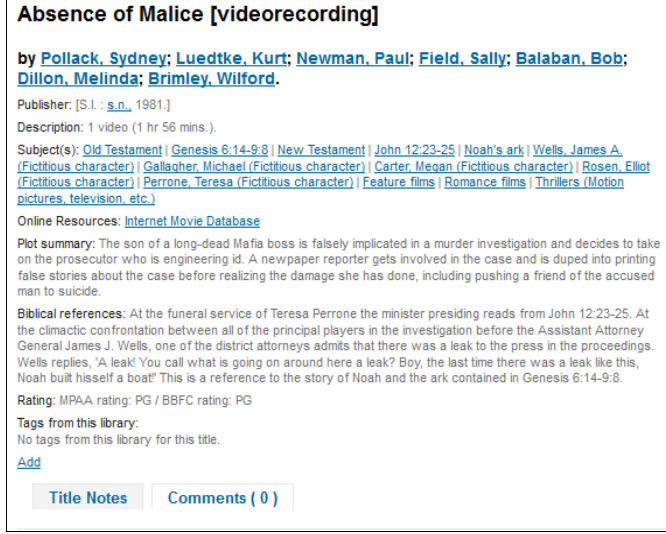
An online catalog view of the Absence of Malice entry—Note the subject and personal name authorities as well as the bolded labels that identify each segment of information; Koha allows authorized patrons to log in and provide comments, a requirement of the